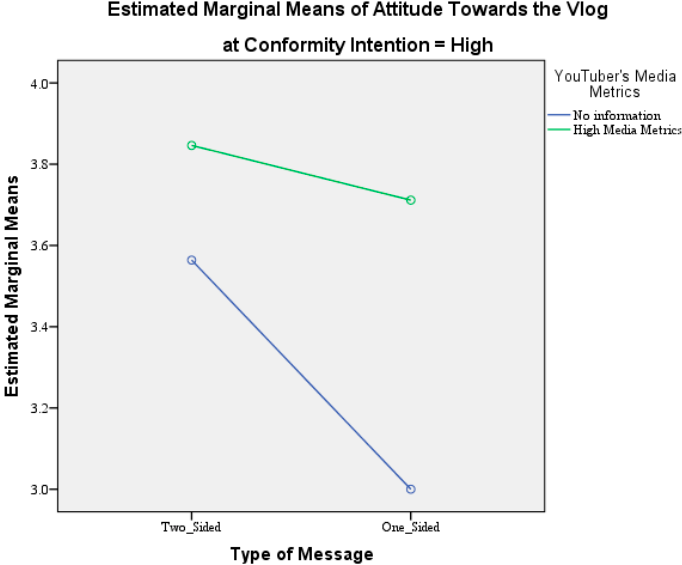
Figure 3. The interaction effect between type of message and YouTuber’s media metrics on attitude towards the vlog for low conformity intention.